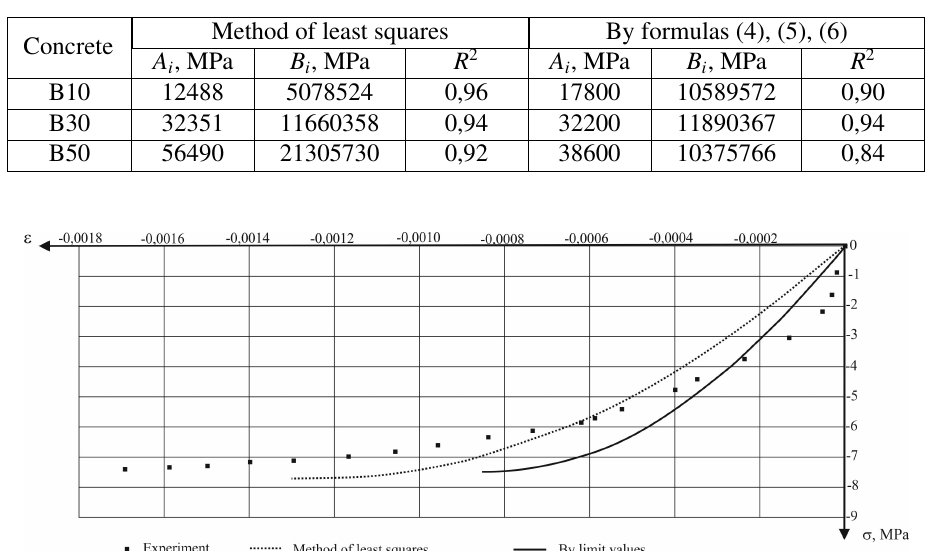
Table 1. The coe ffi cients of approximating curves A i , B i